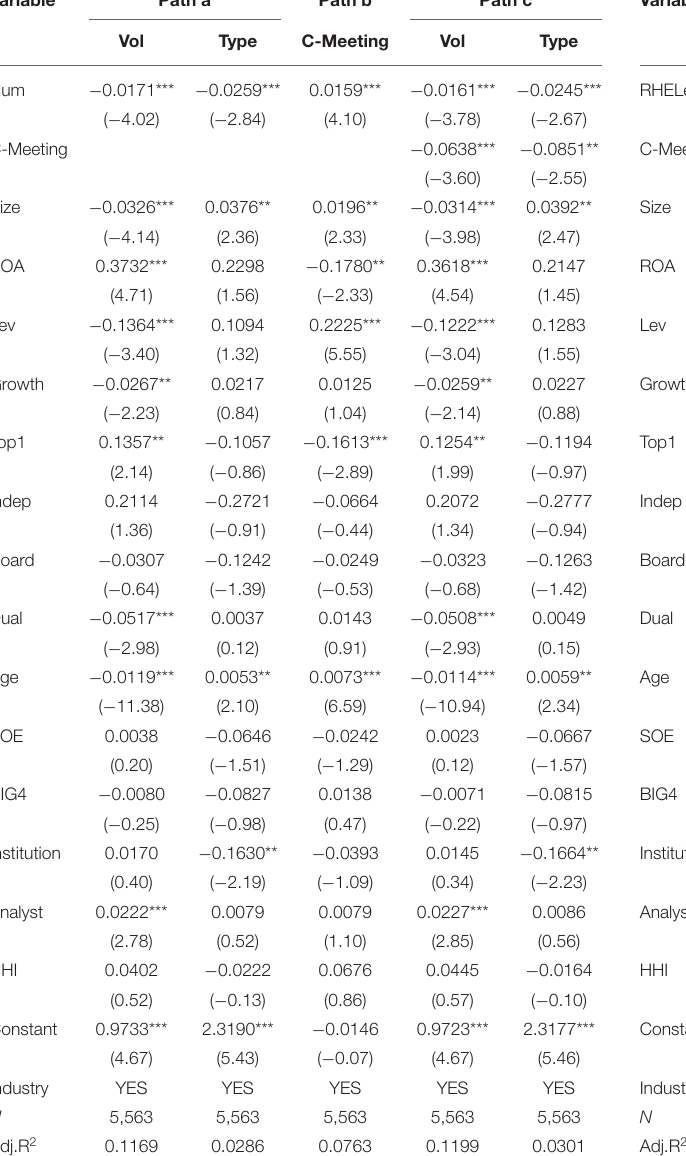
TABLE 7 | Evidence of the impact of directors’ on-site supervision restrictions (X = RHELevel-1).